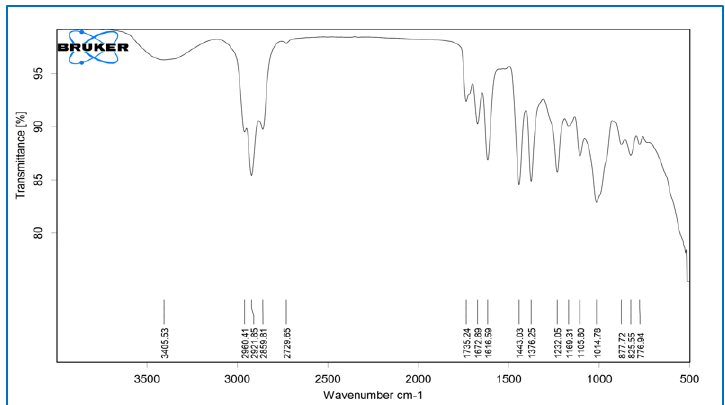
Figure 4. FTIR of Calendula officinalis oil.